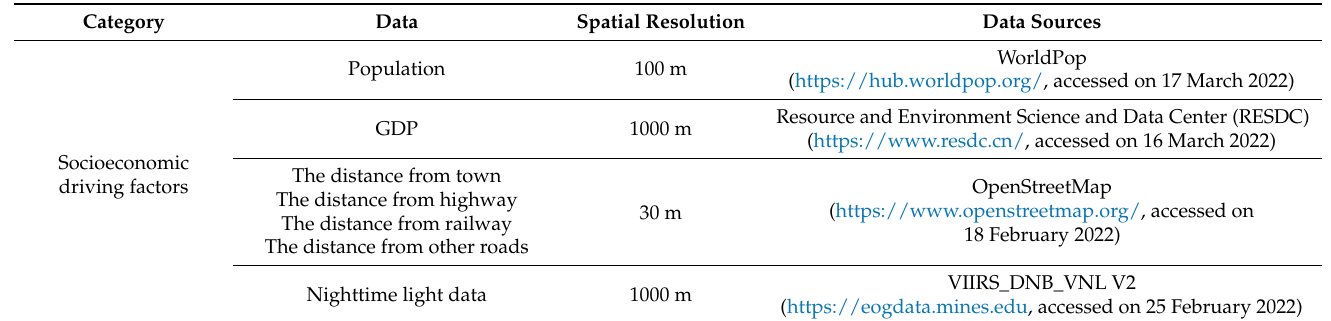
Table A2. The spatial driving factors of the land use